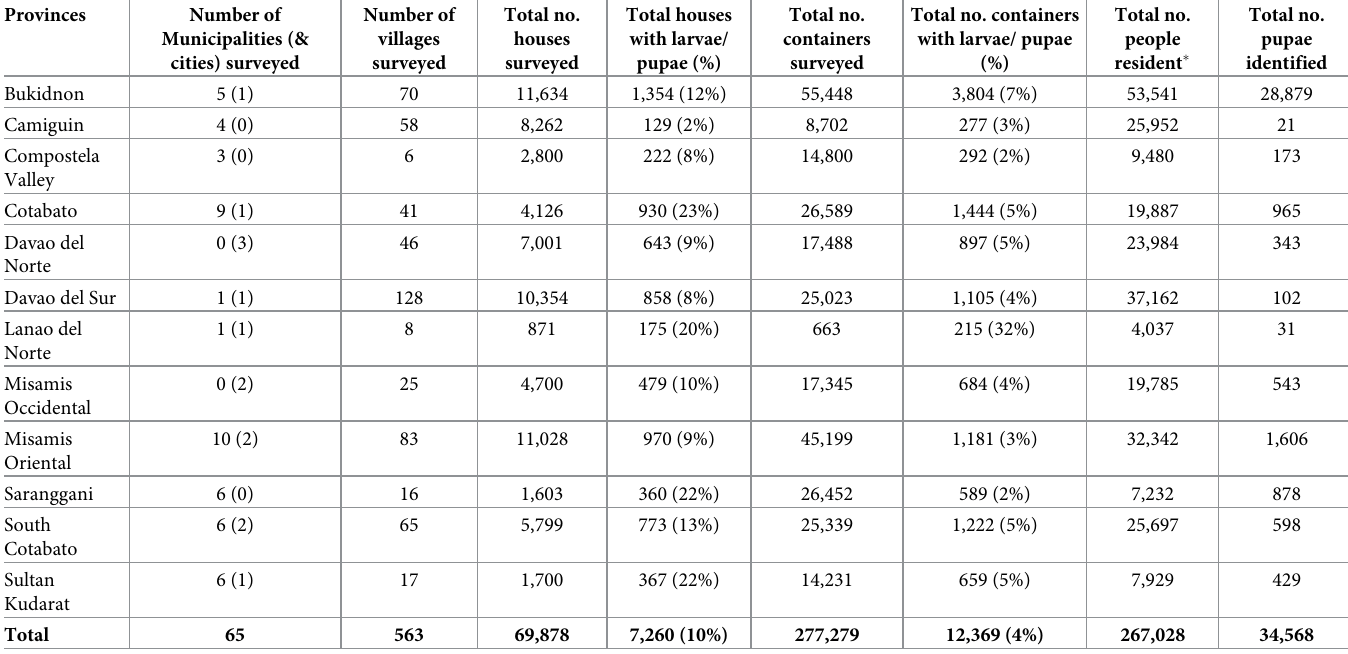
Table 1. Summary of inspections conducted and their findings during the 6-year period: